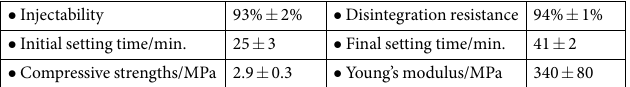
Table 1. Physiochemical properties of PSC/CS